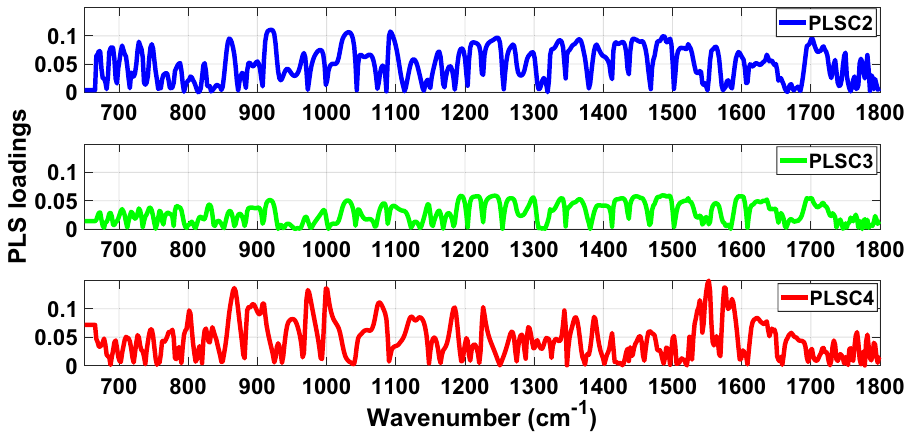
Figure 3. Absolute values of PLS loadings of PLSC2 (blue), PLSC3 (green) and PLSC4 (red) in the fingerprint spectral region between 650–1800 cm −1 for our analysis of the LIQUID 1 dataset.